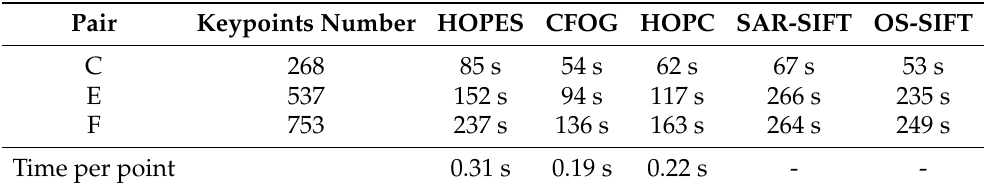
Table 5. The comparison of algorithms